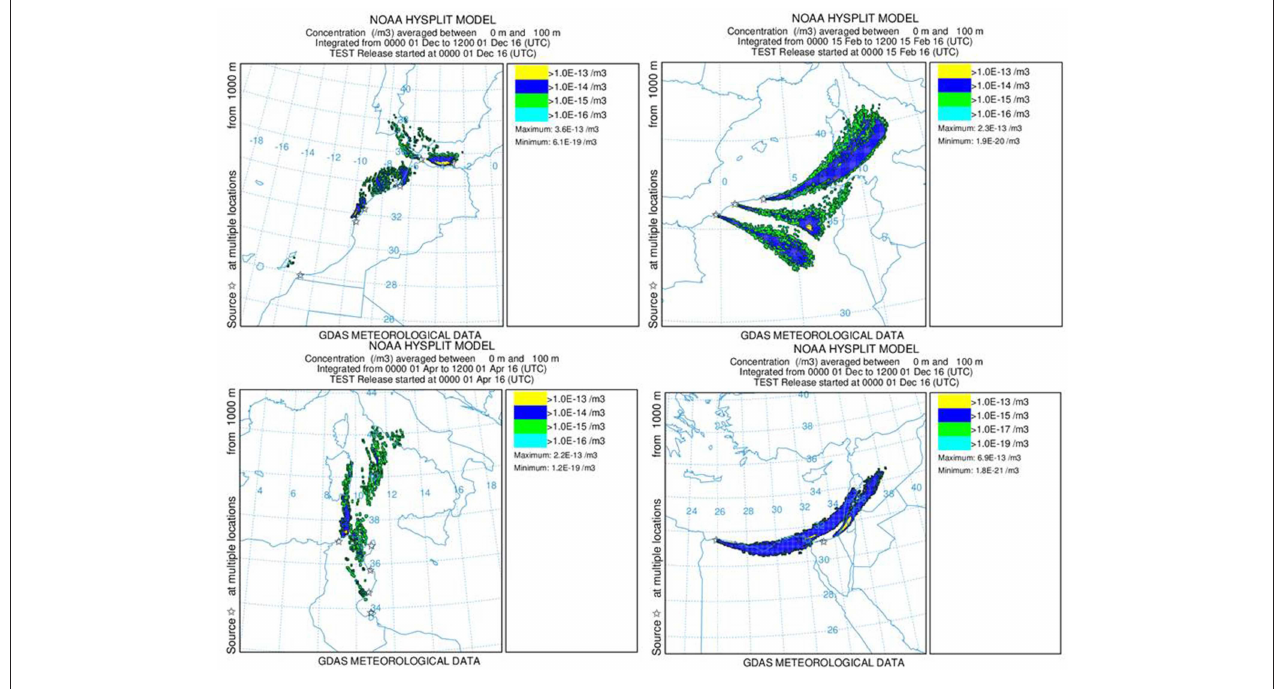
FIGURE 2 | Particle dispersion